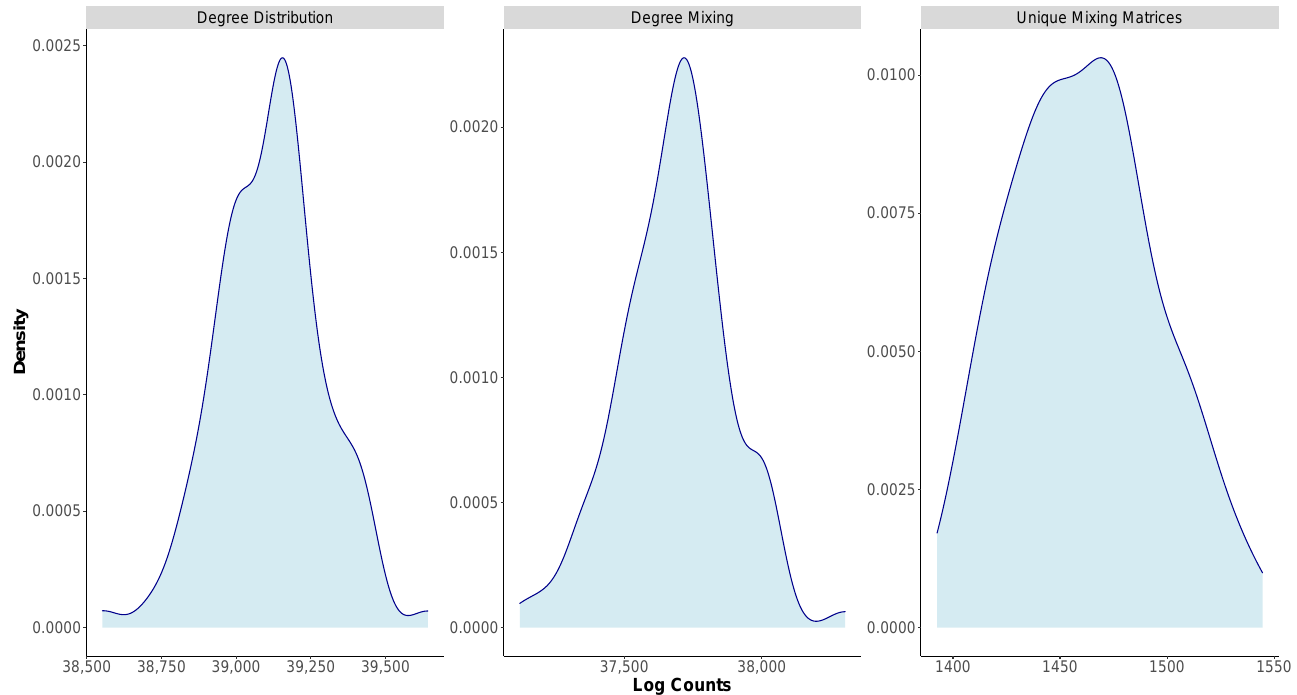
( φ ( G BA )) | (first 2 i 2